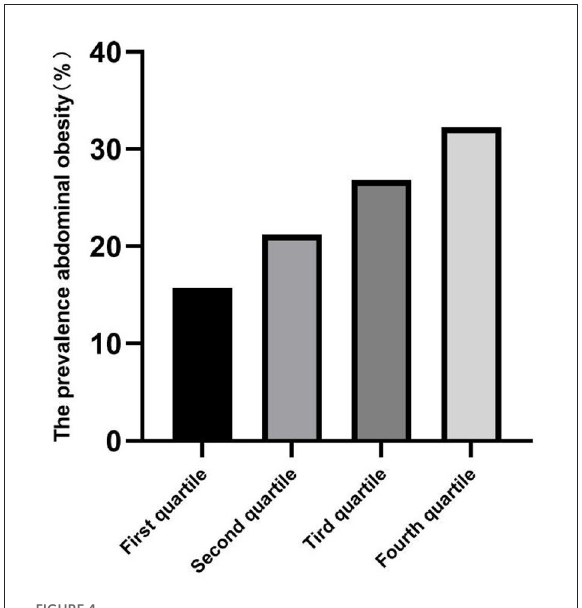
FIGURE4 The prevalence of abdominal obesity among remnant cholesterol (RC) quartiles in urban.